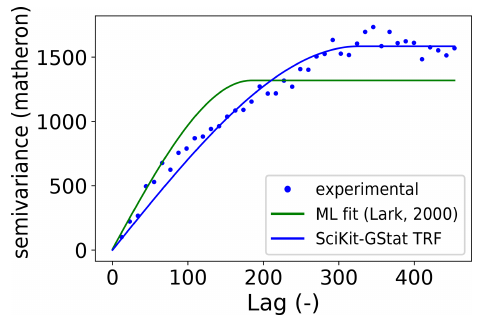
Figure C1. Default SciKit-GStat trust-region reflective fit of the pancake dataset (blue line) to the experimental variogram (blue dots) compared to a maximum likelihood approach following Lark (2000) (green